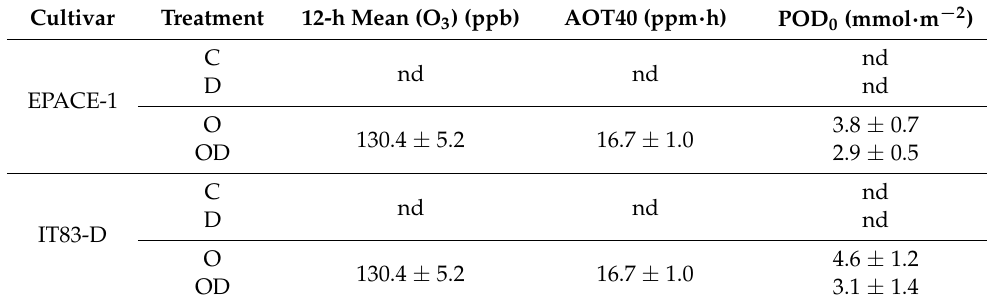
Table 1. Twelve-hour mean ozone concentration and indices of ozone exposure (AOT40, ozone concentrations accumulated over a threshold of 40 ppb) and stomatal uptake (POD 0 , phytotoxic ozone dose, expressed as the accumulated stomatal flux of ozone) to which cowpea plants were subjected in the following treatments: Control (C), Drought (D), Ozone (O), Ozone + Drought (OD). Mean ± SD are shown ( n = 4). Ozone concentration and AOT40 were averaged from the values recorded in 4 identical chambers. Ozone stomatal uptake (POD 0 ) was averaged from 4 biological replicates. Control (C) and drought-treated (D) plants were supplied with activated charcoal-filtered air and ozone concentration was close to zero (nd, not